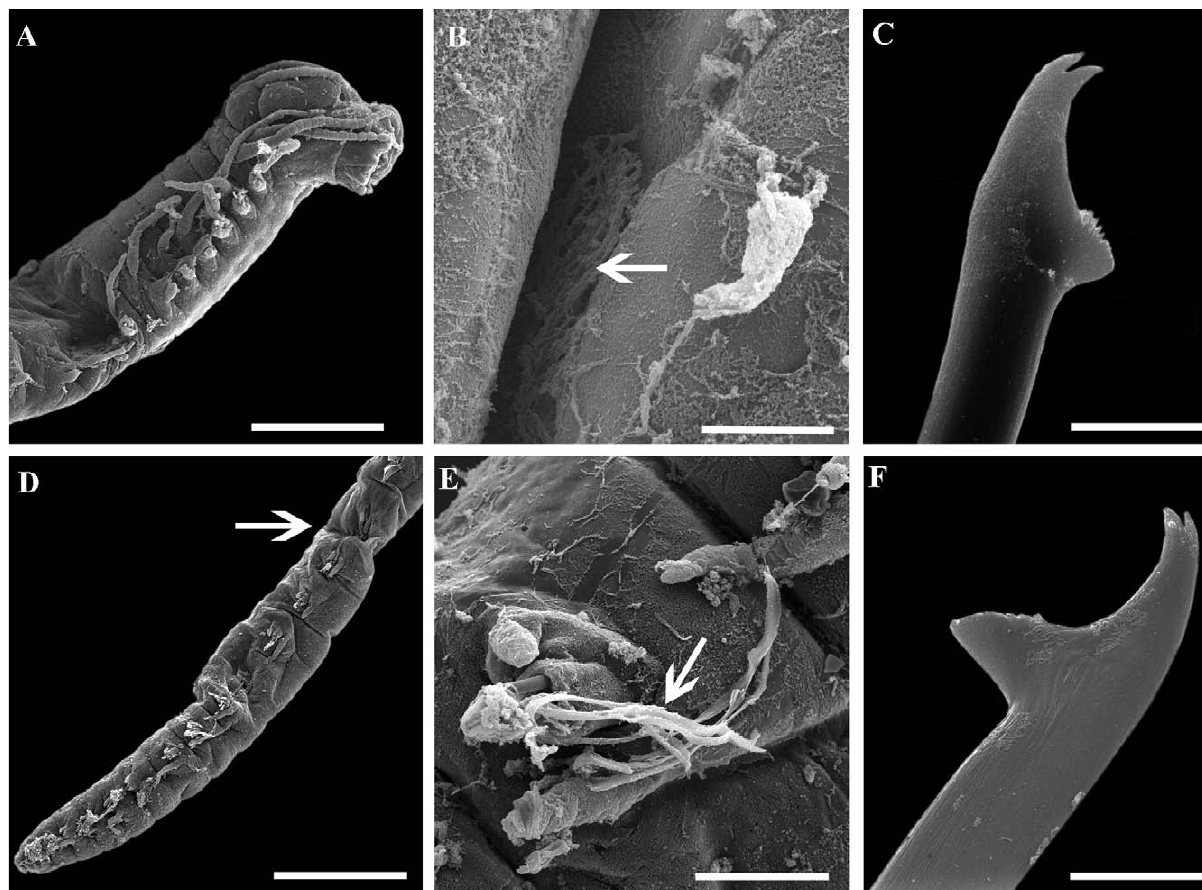
Fig . 17. – SEM micrographs of Haplosyllis niphatesicola n. sp. from Belize. A, anterior end, lateral view. B, detail of nuchal organs, arrow point on cilia. C, anterior chaeta. D, posterior end of a stolonizing specimen, arrow points at the beginning of stolon. E, detail of parapodium of the stolonized region, arrow points to swimming chaetae. F, posterior chaetae. Scale bars: A (400 m m), B (12 m m), C (6 m m), D (500 m m), E (50 m m), F (8.6 m m). MNCN